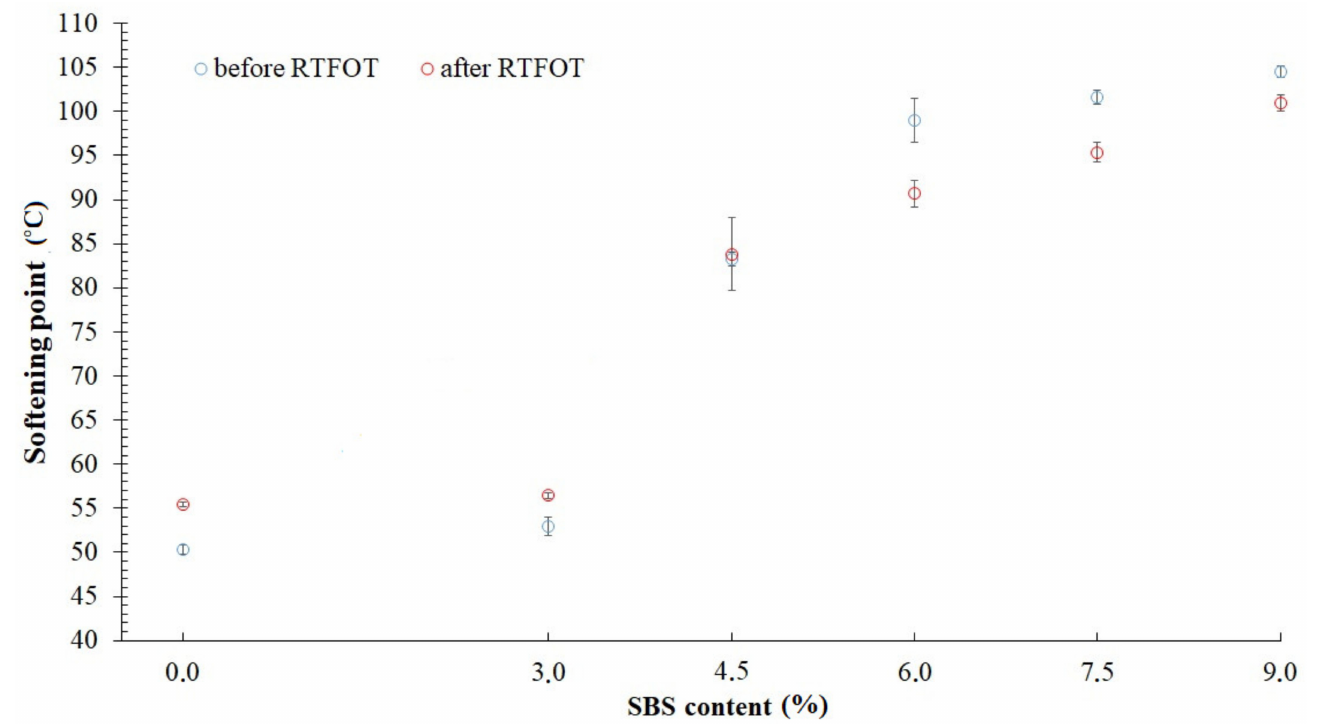
Figure 5. Softening point values of tested asphalt